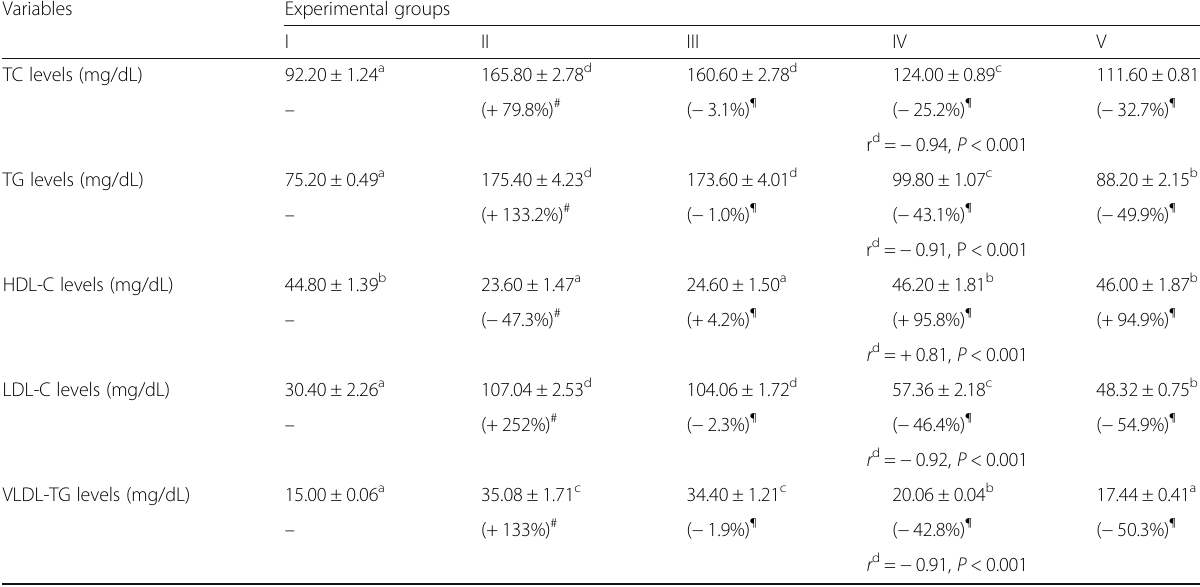
Table 4 The levels of total cholesterol (TC), triglycerides (TG), high- and low-density lipoprotein cholesterols (HDL-C & LDL-C) and very low-density lipoprotein triglyceride (VLDL-TG) in serum of all the experimental groups, at the end of the experiments